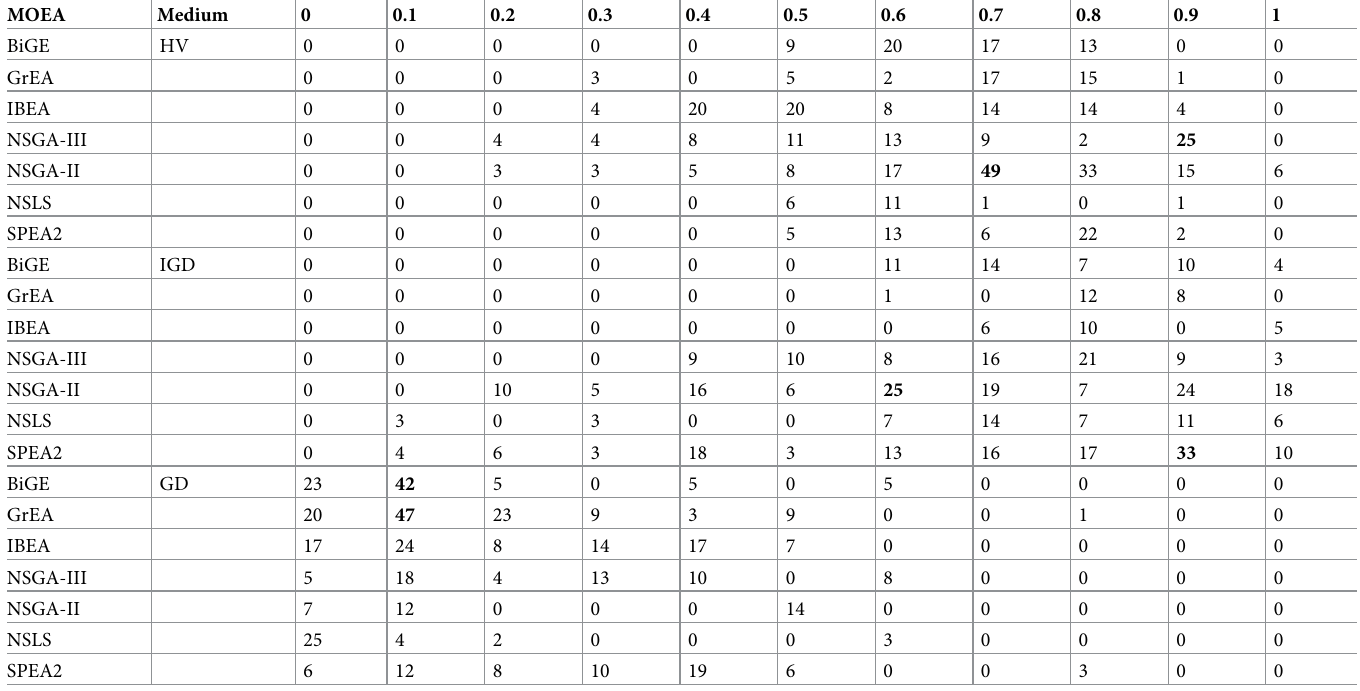
Table 3. Scores of 77 pairs evaluated by HV, IGD, and GD